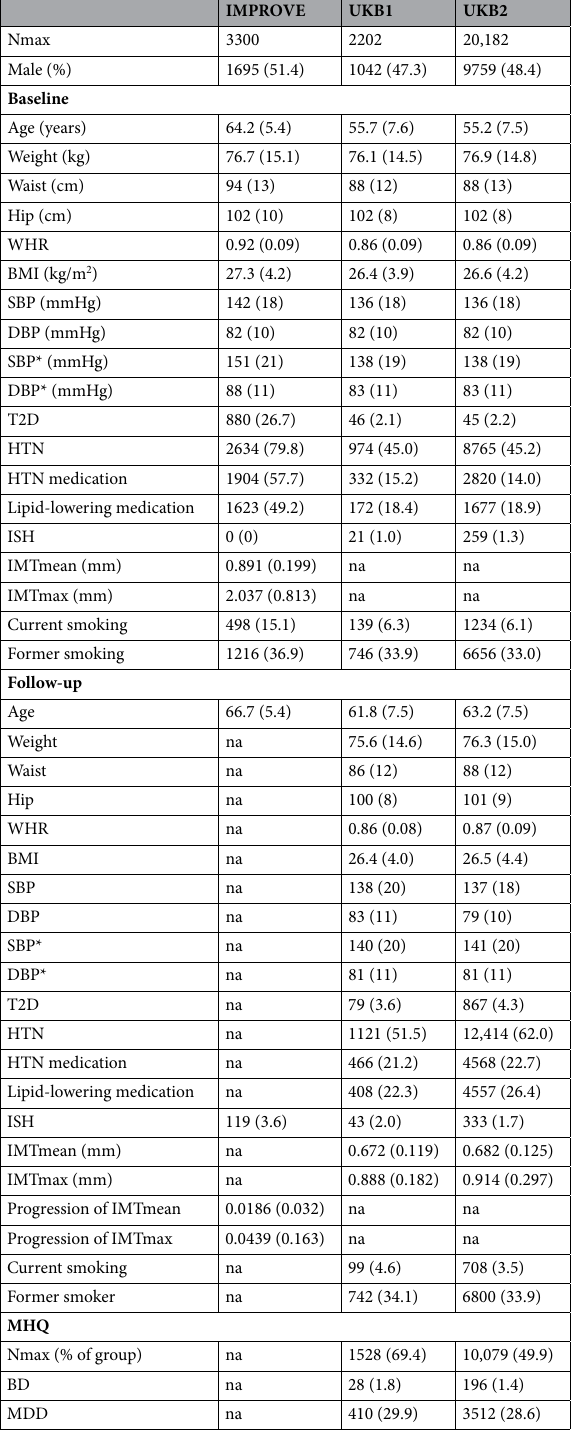
Table 1. Demographic characteristics of IMPROVE and UKB participants. Where: *, adjusted to provide estimates of treatment-naïve levels, as per Ehret etl al; na, not